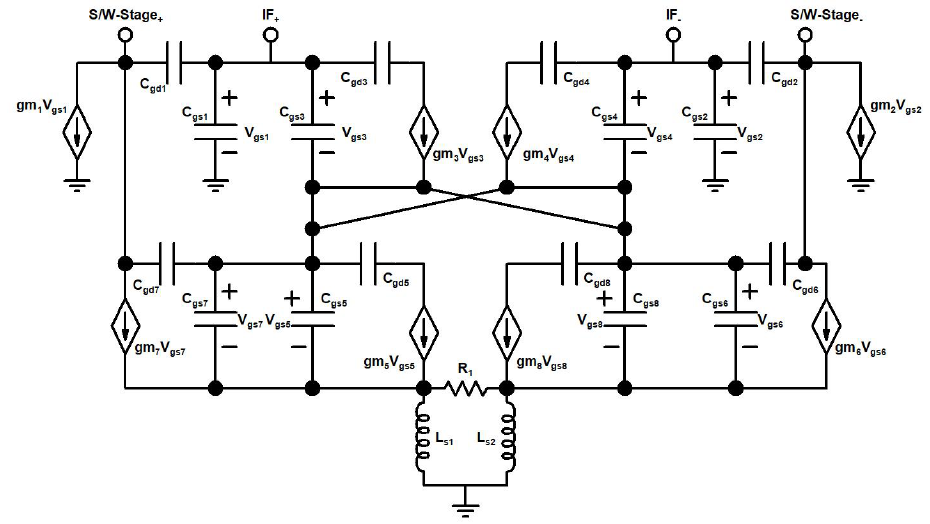
Figure 9. Small signal model of the DTP